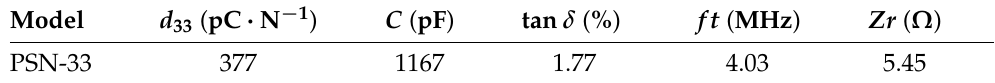
Table 2. The parameters of